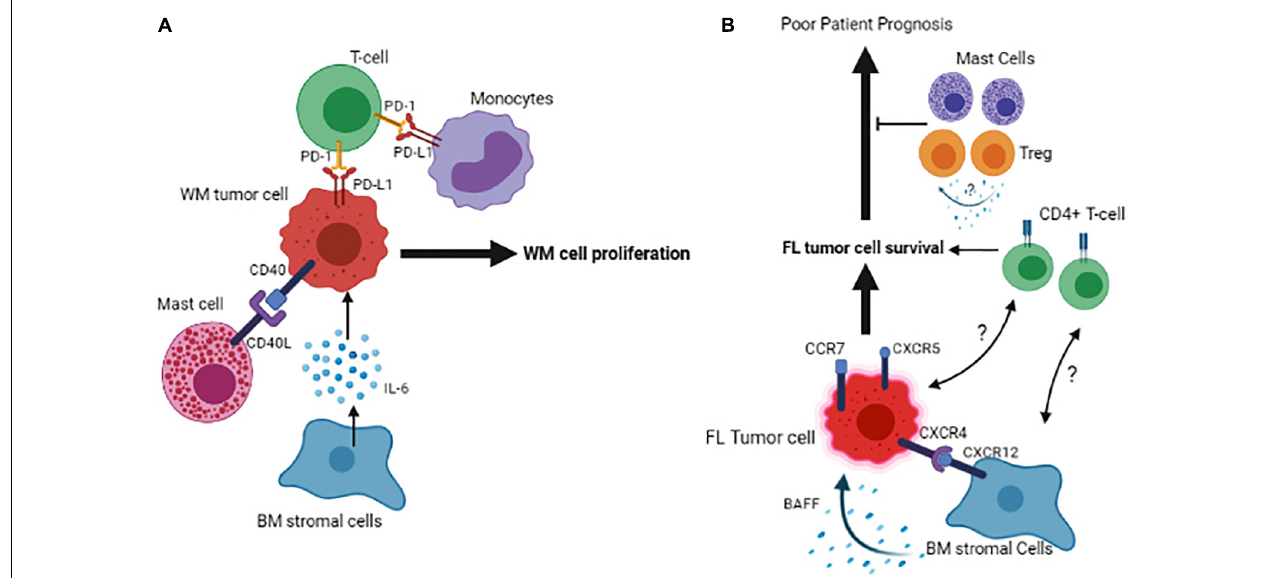
FIGURE 2 | Schematic representation of the tumor cell interactions with its microenvironment in the BM of Waldenstrom Macroglobulinemia (A) and Follicular Lymphoma (B) . Figures are generated by